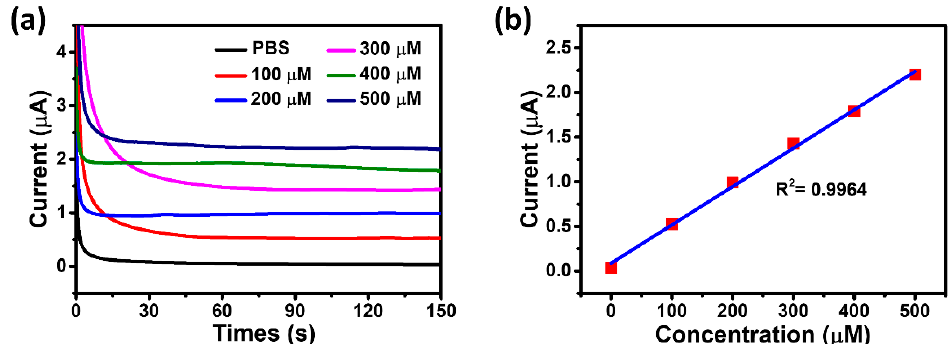
Figure 2. Characterization of the microporous membrane. ( a – d ) Typical SEM images of the microporous membrane at different magnifications. ( e ) Statistical results of the pore size distribution of the microporous membrane and its Kolmogorov–Smirnov test results (the inset shows the mean and standard deviation of pore size of the microporous membrane).